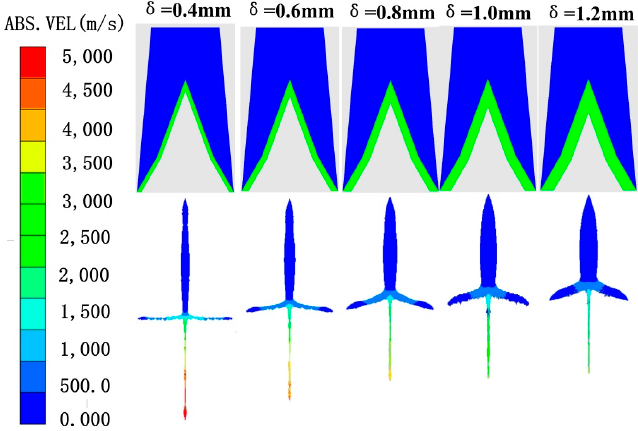
Figure 10. Velocity distribution of different liner thickness.